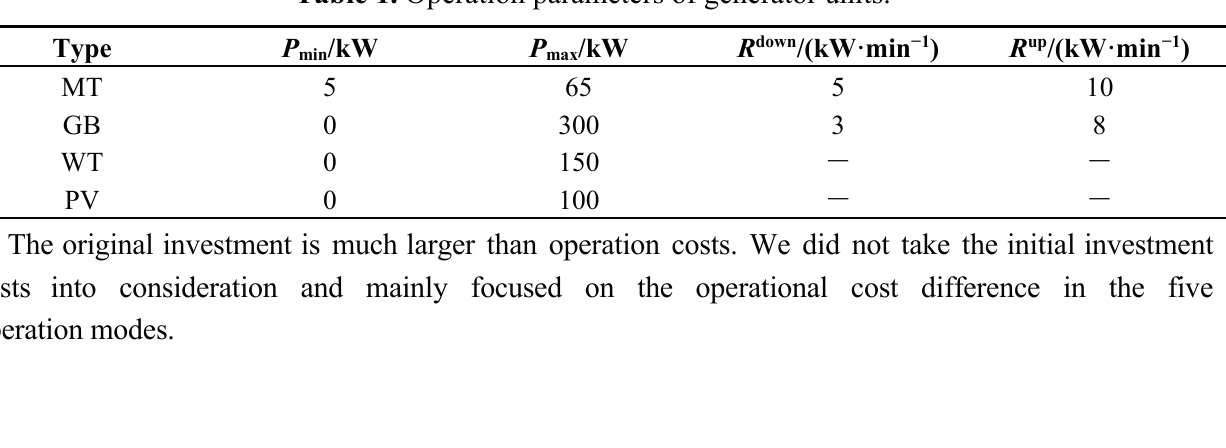
Table 1. Operation parameters of generator